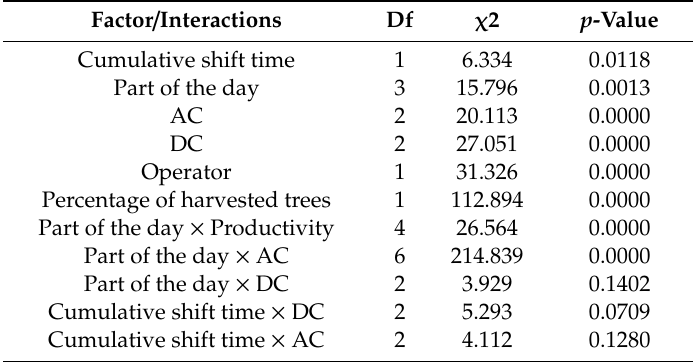
Table 5. Analysis of deviance with Wald chi-square tests (logistic model).